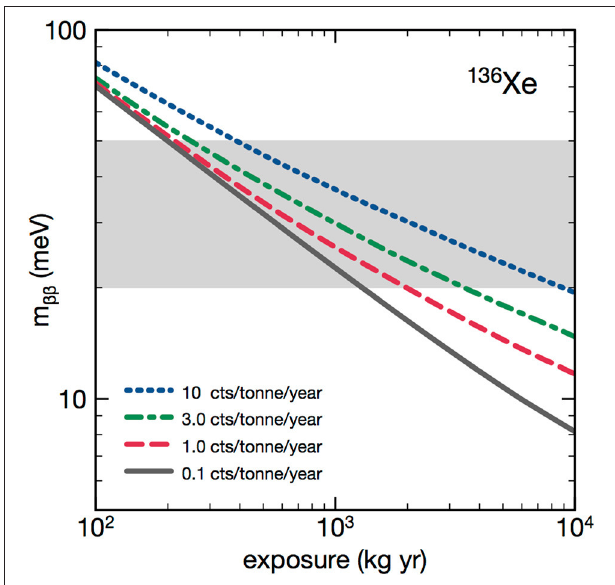
FIGURE 12 | Sensitivity to m ββ of a fully efficient 136 Xe experiment as a function of the exposure, for different background rates